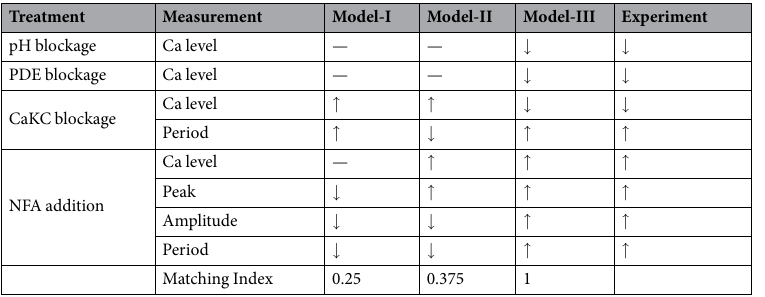
against mammalian proteins. Two main bands were detected with Anti-Cav-PAN (Supplementary Fig. S2B) and Anti-Cav1.2 (Supplementary Fig. S2C), and the corresponding areas were excised from the gel (Supplementary Fig. S2A) and sent to the Proteomics Facility at the Institut de Recherches Cliniques de Montreal, Canada to be sequenced by LC-MS/MS as described 55 . Against expectations, the presence of different unique peptides for three CatSper family members (Catsper 1, 2 and 4) and the β , δ and γ subunits of this channel (Table 1) were identified among other proteins, as reported for Arbacia punctulata 32 . To validate the presence of the CatSper channel in the Triton X-114-extracted flagella membranes, we used an Anti-CatSper1 antibody raised against two peptides (BSYN 6765 and BSYN 6766; Bio-Synthesis, Inc) based on the S. purpuratus CatSper1 predicted sequence (XP_011664201). The stained SDS-PAGE (Supplementary Fig. S2D), was divided in 12, 0.5 mm sections and sequenced by LC-MS/MS. Supplementary Fig. S2E shows the WB of the 1st (line 1) and 2nd (line 2) Triton X-114-extracted flagella membranes labelled with Anti-CatSper1 (1:1000). Although the calculated MW for CatSper1 is 54440 Da, we did not observe it under these conditions in which CatSper1 forms different aggregates. Catsper beta and gamma were identified in the area indicated by “ * ” (sections 5 & 6) in the stained SDS-PAGE. None of the bands analyzed by LC-MS/MS contained Cav channels suggesting that they are in very low rep- resentation in the flagella membranes comparing with the CatSper channel, or absent. Additionally, we identified by tandem mass spectrometry exclusive unique peptide sequences for a calcium-activated potassium channel in